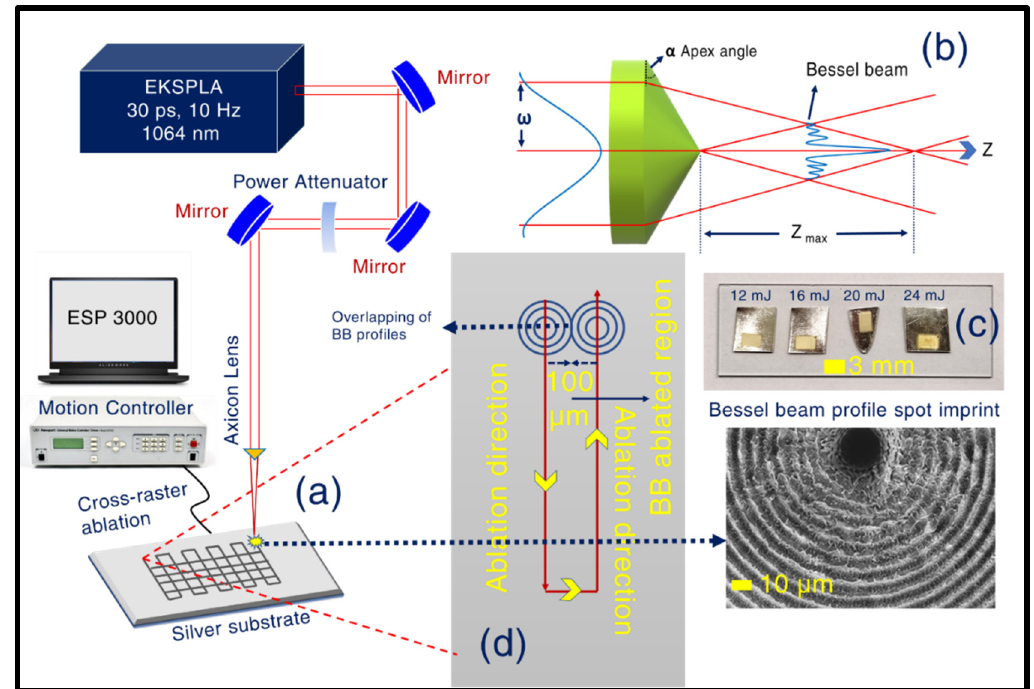
Figure 1. ( a ) Schematic of the experiment involving BB ablation in the air on Ag. The cross-raster scanning employed is also depicted in the figure with BB profile imprint observed at the initial ablation spot (indicated by the dashed line and inset), ( b ) Axicon prism lens and the generated BB, ( c ) pictures of the fabricated silver NSs with different input pulse energies (12 mJ, 16 mJ, 20 mJ, and 24 mJ), ( d ) Schematic of overlapping two BB profiles during the first raster scan.